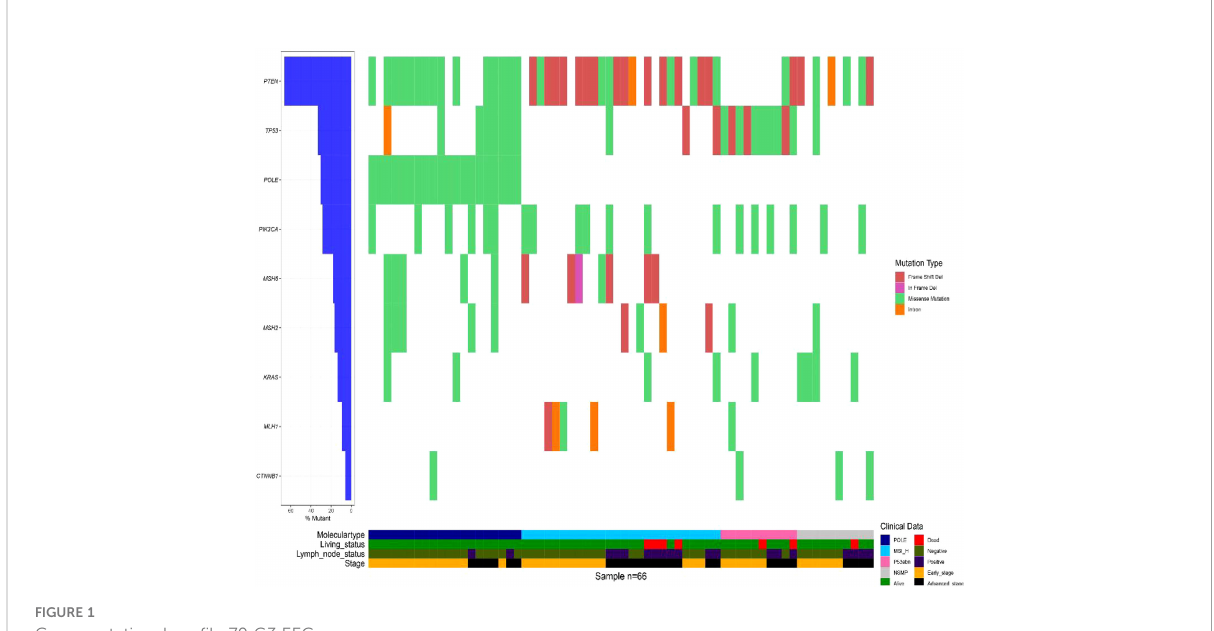
FIGURE 1 Gene mutational pro fi le 70 G3